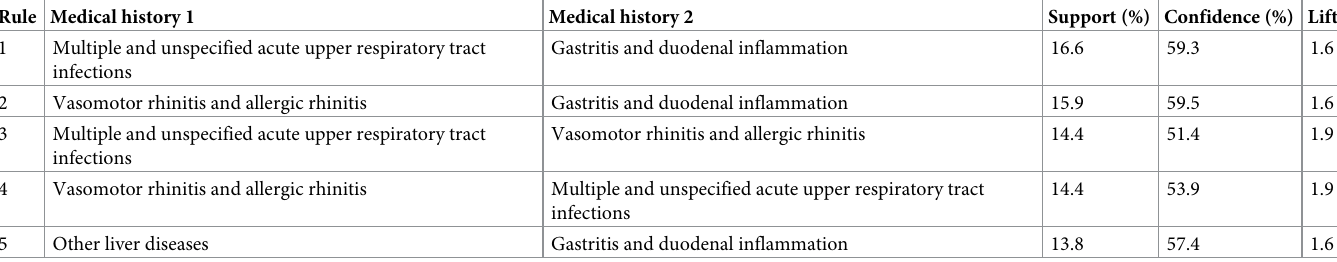
Table 2. Association rules for complications after the onset of depression for patients with X = other anxiety disorders and Y = sleeping disorder. Rule Medical history 1 Medical history